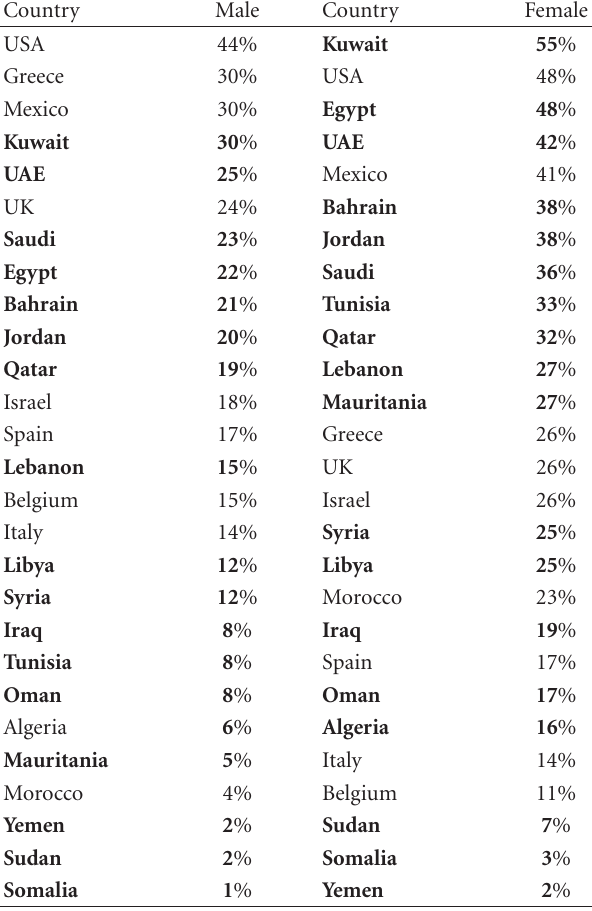
Table 1: Ranking of the prevalence of obesity in Arabic and non- Arabic-speaking countries. The data are separated for males and females aged between 15 and 100 years, using WHO estimates for 2010. Arabic-speaking countries are shown in bold.